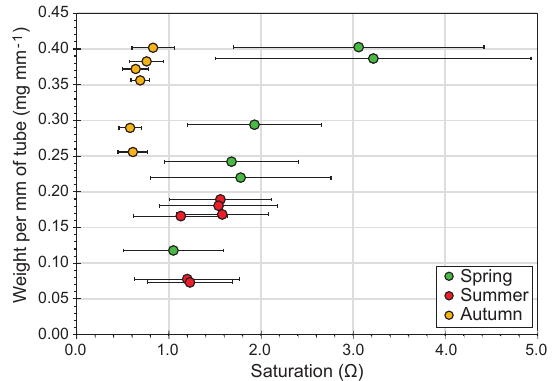
Figure 13. Weights of S. spirorbis tube segments that grew during the spring, summer and autumn experiments. Data points are aver- age weights per millimetre of tube of selected basins (Table S1), plotted against average saturation state. Vertical error bars ( ± 1% of measured weight) are smaller than the symbols. Horizontal error bars ( ± 1SD) represent the variability of saturation in each basin during the experiments.